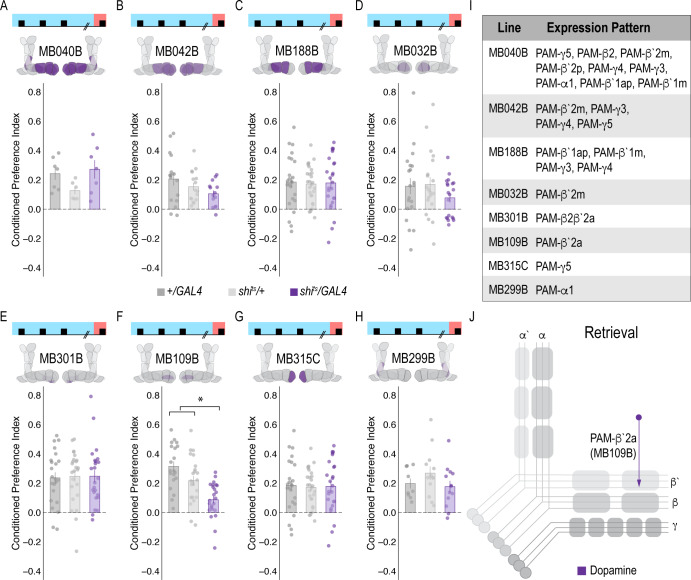
Memory expression during retrieval is dependent on a sparse population of DANs.(A–H) A thermogenetic approach was used to inactivate neurotransmission during retrieval, but not acquisition, in PAM DANs with varying expression patterns. (F) Inactivating β`2a DANs during retrieval significantly reduced preference for alcohol-associated cues. One-way ANOVA with Tukey Posthoc was used to compare mean and variance. F(2,65)=14.18, p=7.78×10^−6. Bar graphs illustrate mean +/- standard error of the mean. Raw data are overlaid on bar graphs. Each dot is an n of 1, which equals approximately 60 flies (30 per odor pairing). (I) Chart illustrating the expression pattern of each split-GAL4 tested with intensity ranges of 2–5 (Aso et al., 2014a). (J) Model of circuits responsible for expression of alcohol-associated preference during retrieval, which highlights the importance of sparse subsets of dopaminergic activity during retrieval for the expression of alcohol-associated preference. *p<0.01.